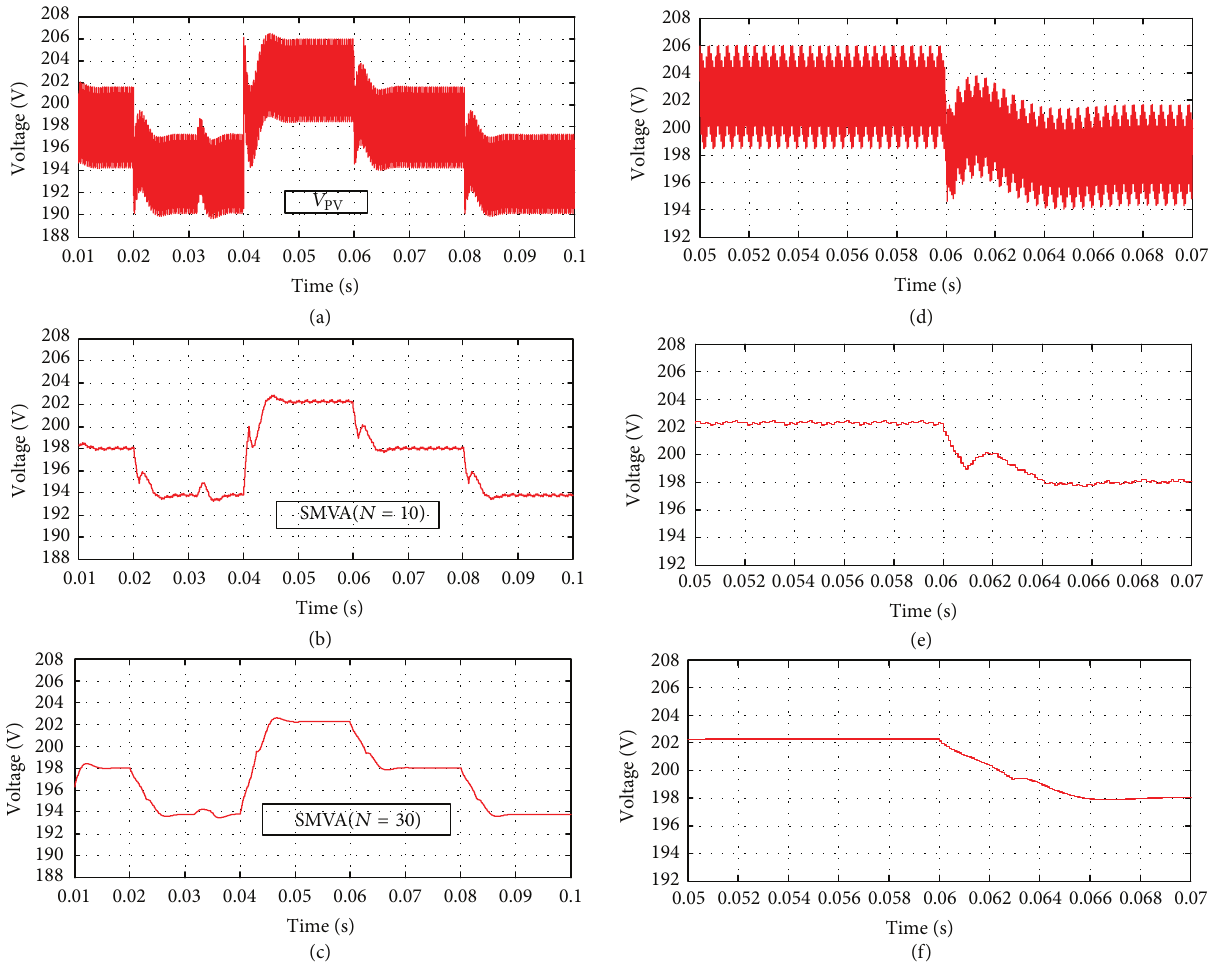
Figure 10: Simple moving voltage average filter. In (a) 𝑉 PV , (b), and (c), this signal is filtered output 𝑉 PV with SMVA, and (d), (e), and (f) are zoomed from (a), (b), and